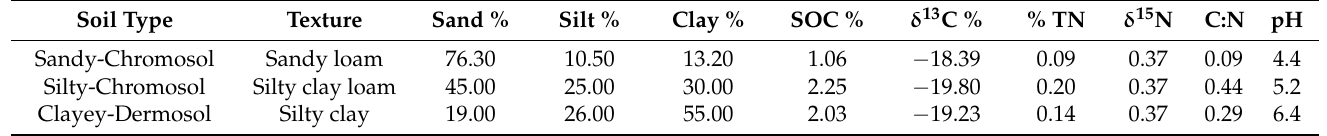
Table 5. Physical and chemical characteristics of the soils used for the biomass production and decomposition experiments.